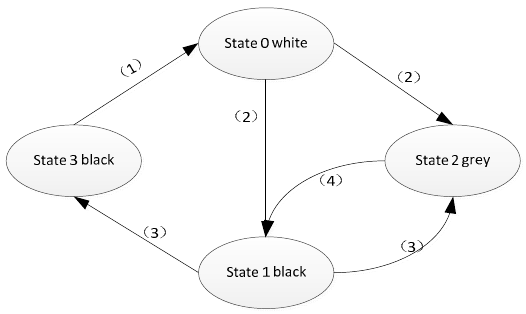
Figure 2. The node states transition diagram.